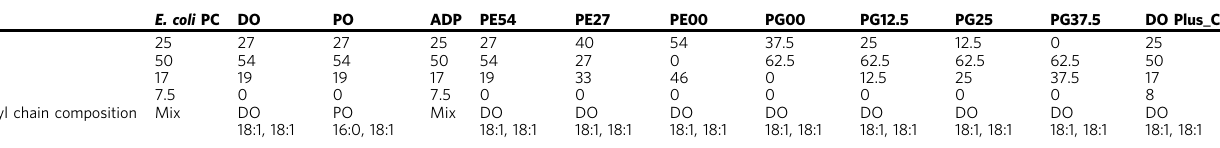
Table 2 Summary of the lipid ratios in